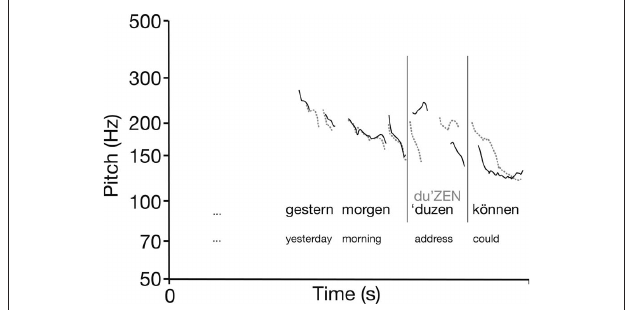
Figure 2 | exemplary pitch contours of critical sentence fragments: correct condition (black) and metric violation